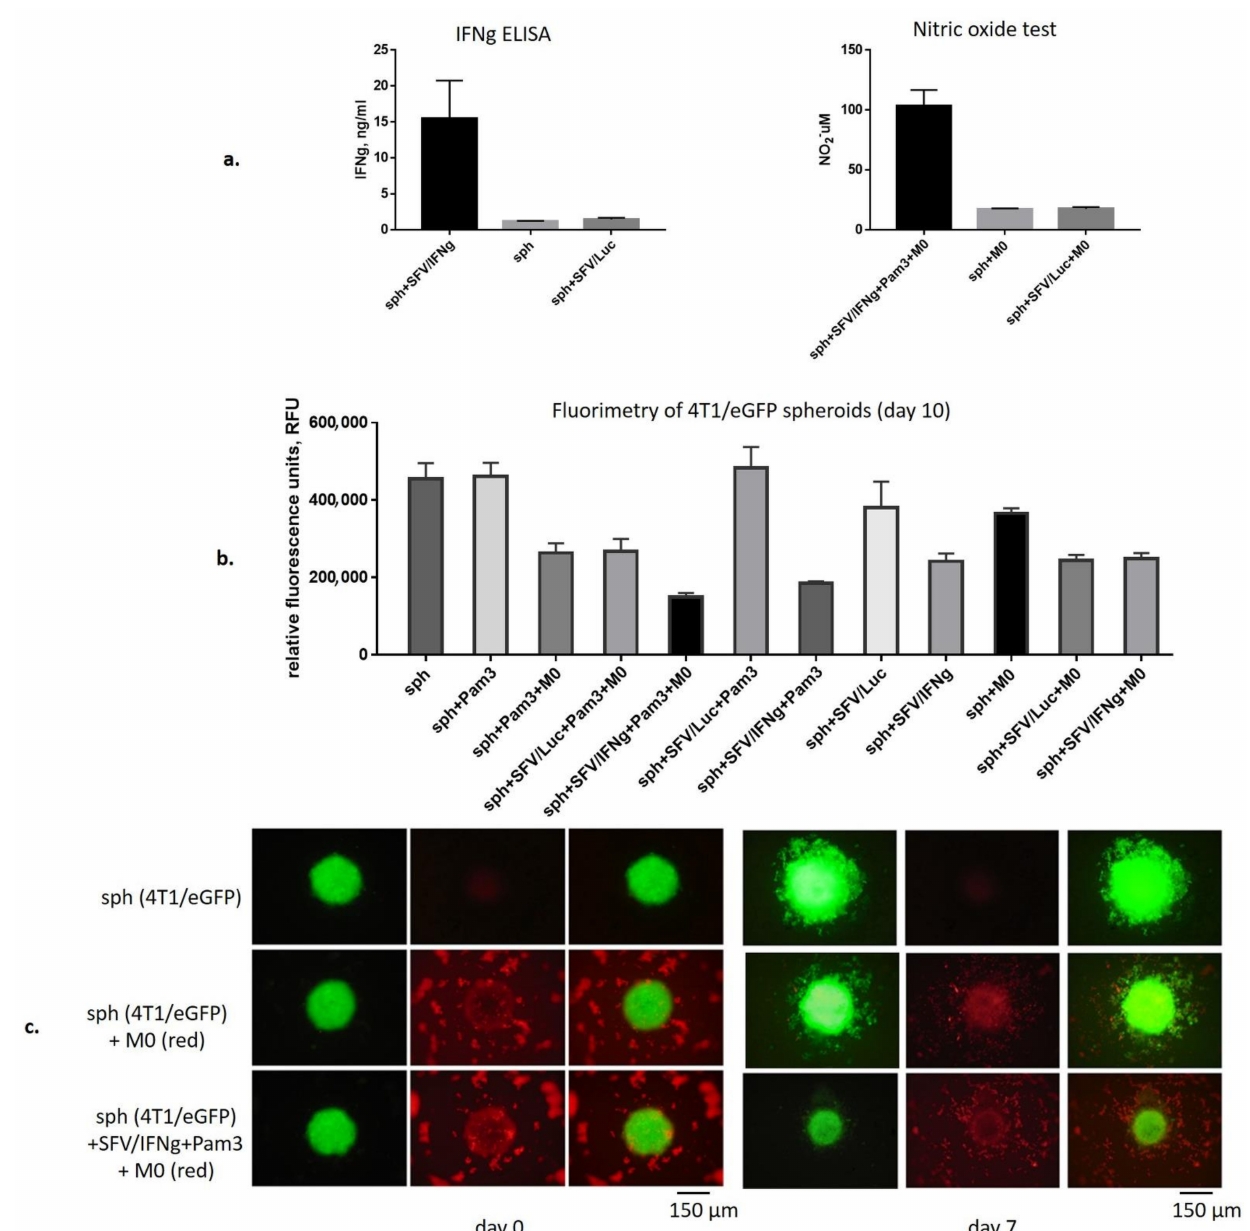
Figure 3. Coculturing of SFV/IFNg-infected 4T1/eGFP spheroids with macrophages. Single 4T1/eGFP spheroids were generated from 3000 cells in 96-well ultralow attachment plates. The next day, the spheroids were infected with either SFV/IFNg or SFV/Luc (5 × 10 4 i.u./well) or incubated with PBS as the uninfected control. The next day after infection, BMDMs (3 × 10 4 cells/well) were added to the spheroids (+M0, day 0). In total, twelve combina- tion groups (six single spheroids in each group, n = 6) were prepared: sph—uninfected spheroids (PBS); sph+Pam3; sph+Pam3+M0; sph+SFV/Luc+Pam3+M0; sph+SFV/IFNg+Pam3+M0; sph+SFV/Luc+Pam3; sph+SFV/IFNg+Pam3; sph+SFV/Luc; sph+SFV/IFNg; sph+M0; sph+SFV/Luc+M0; sph+SFV/IFNg+M0. Pam3 was added to a final concentration of 100ng/mL to respective groups. ( a ) The production of vdIFNg by spheroids was measured in cell culture supernatants by ELISAs 18 h after infection, before the macrophages were added. The production of NO by macrophages was measured in cell culture supernatants after two days of incubation with infected spheroids. ( b ) The total eGFP fluorescence measured by fluorimetry at day 10 of the incubation. ( c ) Representative fluorescence microscopy images of spheroids incubated with prestained macrophages (red) at day 0 and day 7. Bars represent the mean values ± SD, n = 6. We concluded that SFV infection in combination with macrophages provided the most significant inhibition of spheroid growth (Figure 3b). The inhibitory effect of